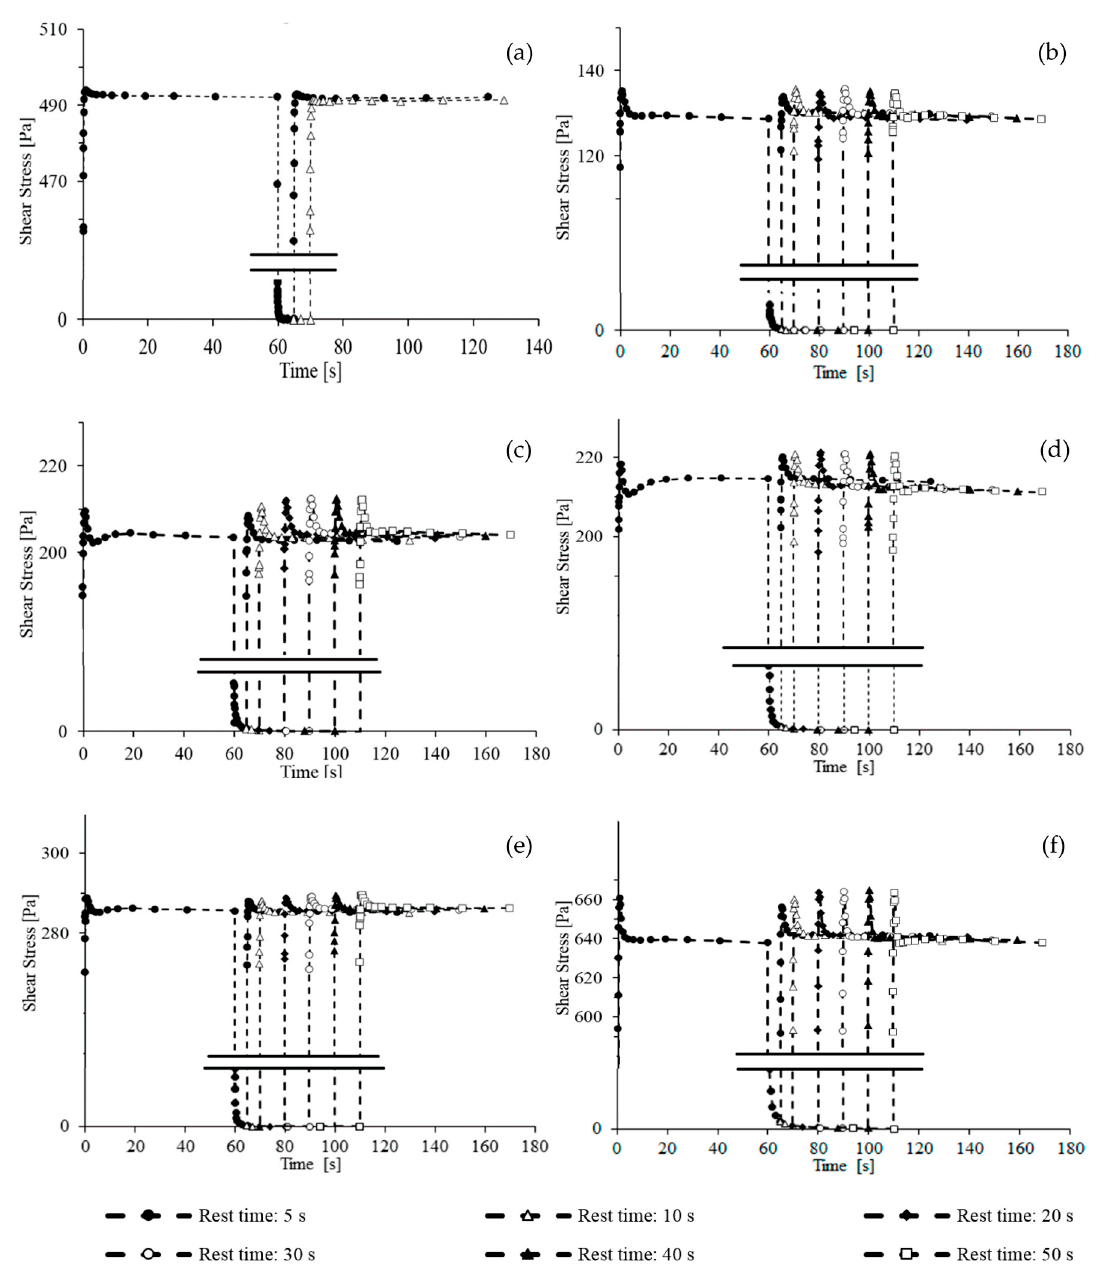
Figure 5. Stress growth in the interrupted shear flow of ( a ) the original asphalt (PG64-22), ( b ) AR-BGR25-10LP, ( c ) AR-BGR50-15LP, ( d ) AR-BGR50-20LP, ( e ) AR-BGR75-10LP, and ( f ) AR-BGR75-20LP. T = 64 ◦ C and a shear rate of 2 s − 1